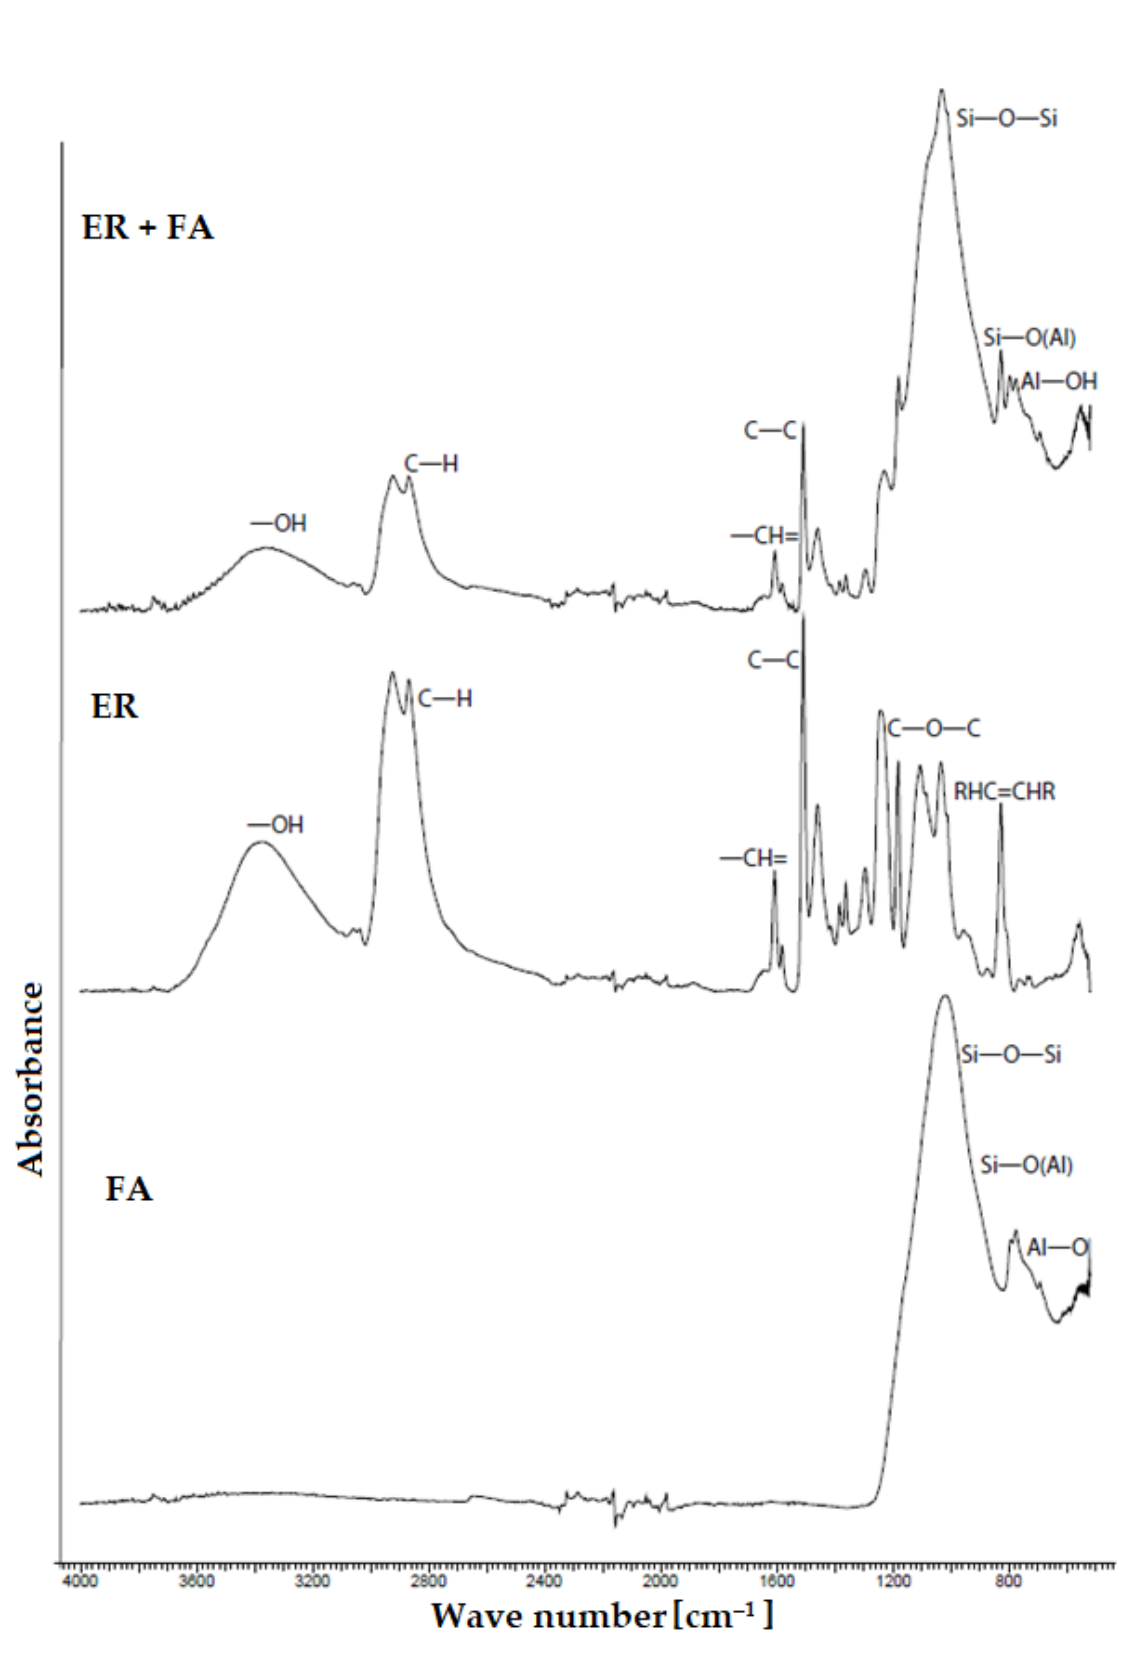
Figure 21. FTIR analysis—comparison of spectrums of fly ash (FA) with epoxy resin, pure epoxy resin (ER) and FA.